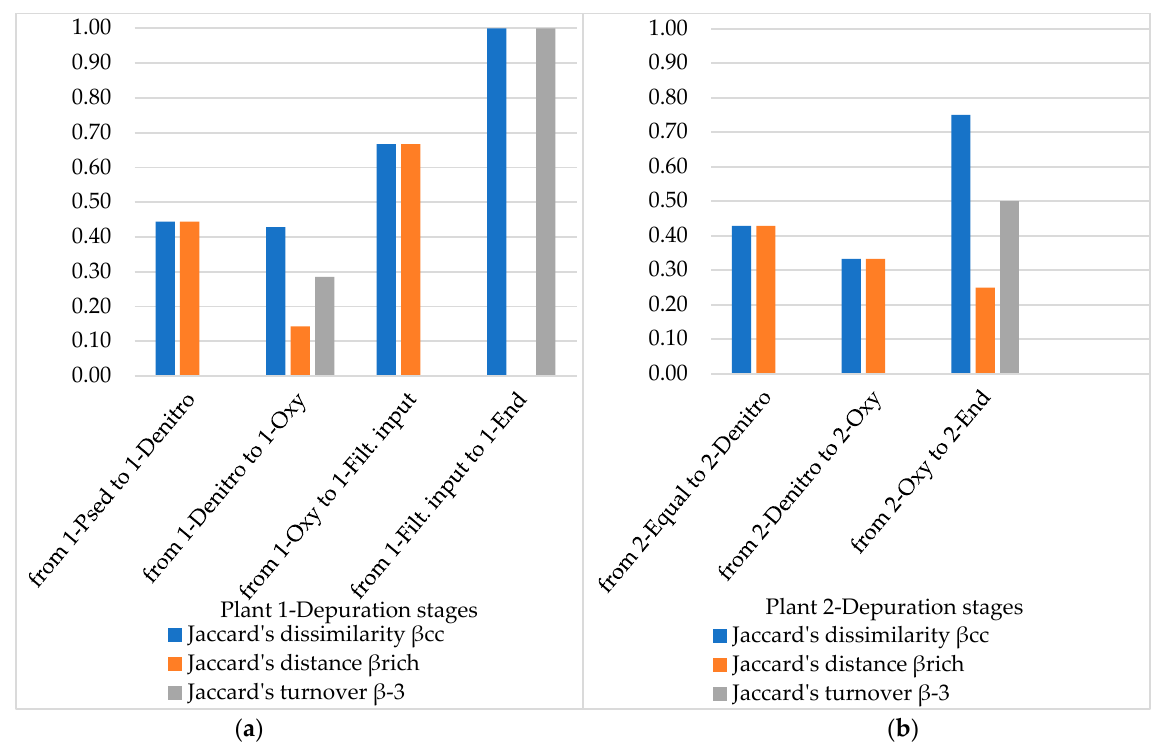
Figure 6. Pairwise distance and directional turnover based on Jaccard’s models at an Order scale in different depuration stages in Plant 1 ( a ) and Plant 2 ( b ).